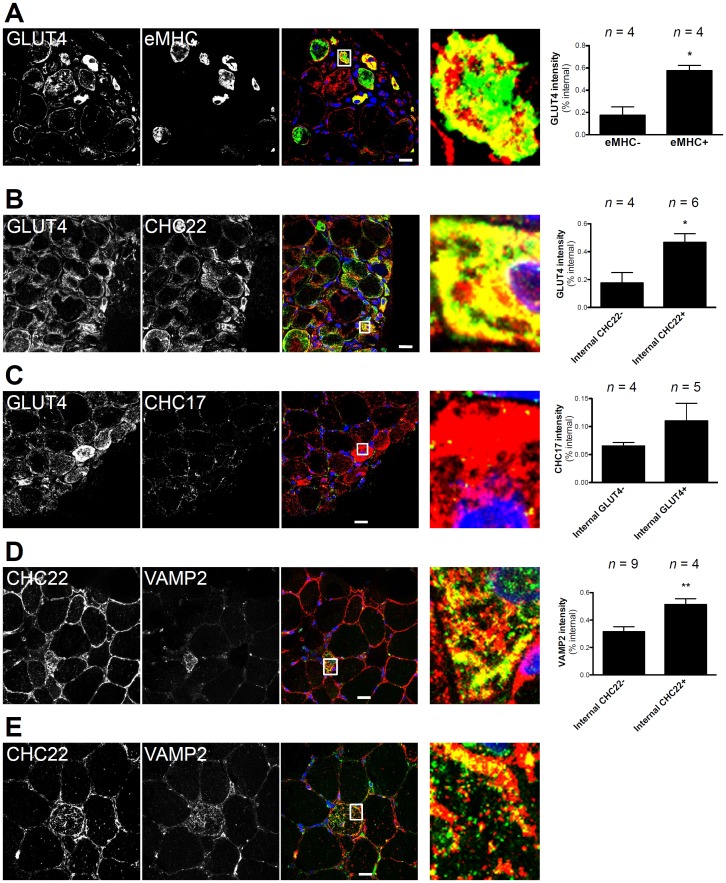
Co-localization of CHC22 and components of the GLUT4 trafficking pathway in regenerating human muscle.A, B and C) Transverse sections of skeletal muscle from a patient with PM were immunostained with a polyclonal antibody against GLUT4 (red) and monoclonal antibodies against A) embryonic myosin heavy chain (eMHC, green), B) CHC22 (green) or C) CHC17 (green). Regenerating myofibers were identified by centrally located nuclei stained with DAPI (blue in merge). Boxed regions in the merged images are magnified seven-fold at the right showing overlap of markers in yellow (scale bars, 20 µm). D and E) Transverse sections of skeletal muscle from a patient with PM were immunostained with a polyclonal antibody against CHC22 (red) and a monoclonal antibody against VAMP2 (green). Regenerating myofibers were identified by centrally located nuclei stained with DAPI (blue in merge). Boxed regions in the merged images are magnified seven-fold at the right showing intracellular co-localization (yellow) of CHC22 and VAMP2 in a regenerating fiber of D) small diameter or E) large diameter (scale bars, 20 µm). At the far right, the percent internal staining for the markers indicated on the y-axis was quantified as in Figure 1F, for fibers that were characterized according to internal staining for the marker indicated on the x-axis. n is the number of fibers analyzed in each staining combination shown at the left. Significant increased internal staining was determined by Student’s t-test (*p<0.05, **p<0.01).